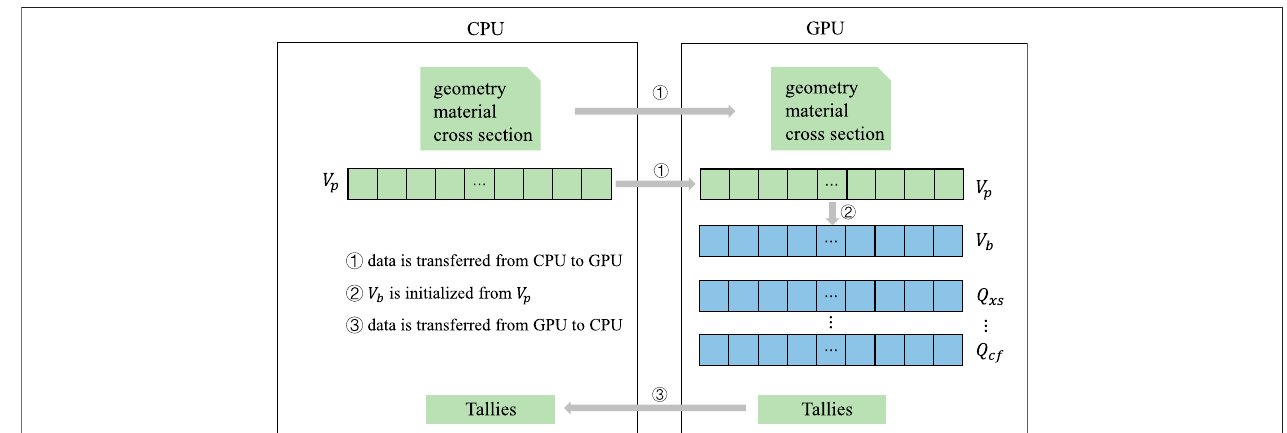
FIGURE 2 | Memory management of main data structures in the event-GPU algorithm.